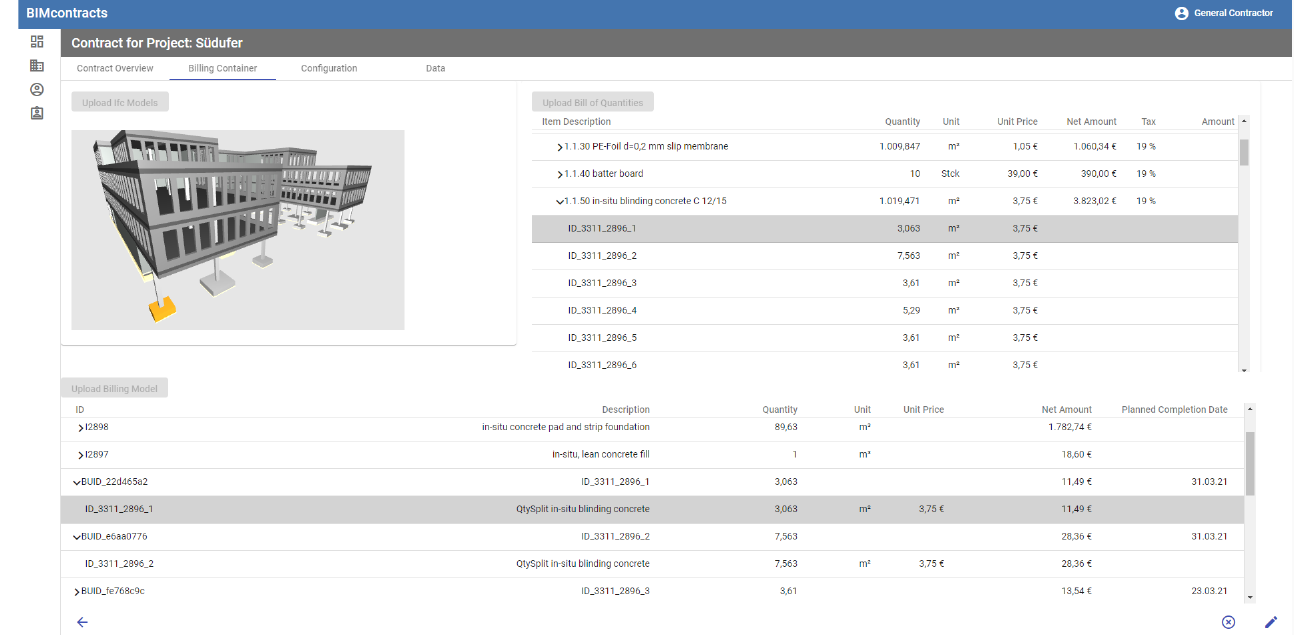
Figure 10. Visualization of the imported billing container (linked IFC model, BoQ with QTO and billing plan) in the BIMcontracts application.